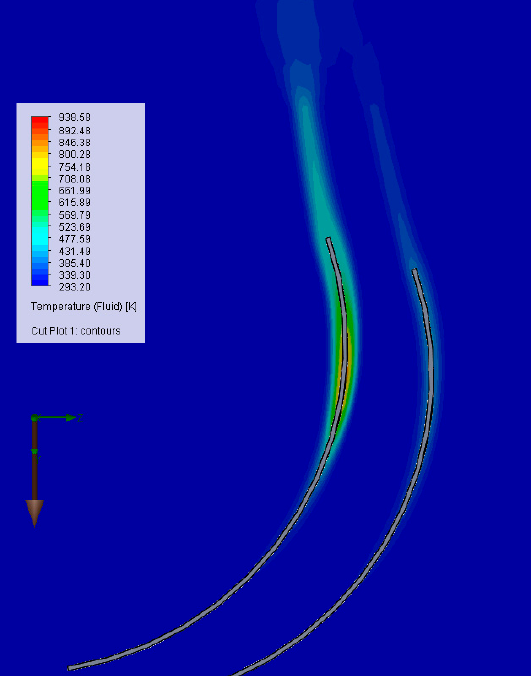
Figure 27. Air temperature at 660 s.